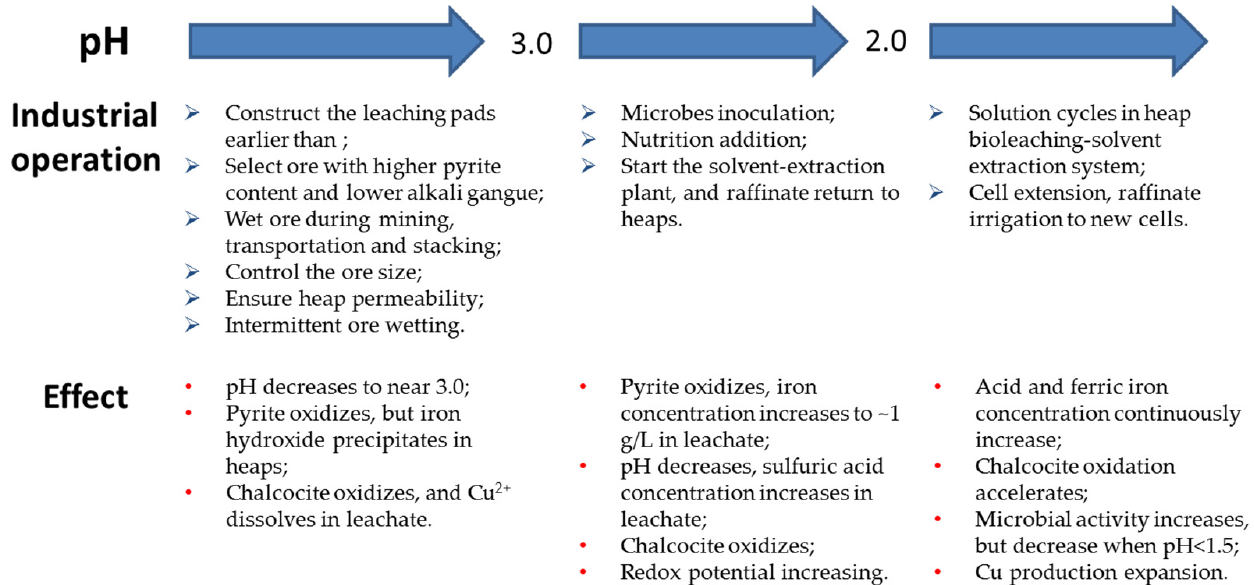
Figure 2. Scheme of the heap bioleaching started with only water irrigation. (1) pH > 3.0: Ore was wetted using river water at the ratio of about 4% during mining, truck transportation and stacking, for dust suppression and most important for starting the sulfide mineral oxidation. The cells were designed by the multi-lifts, and heap height were 6 m of each lift. No agglomeration and aeration were applied during heap bioleaching. Irrigation pipelines were installed immediately and irrigated on time with water to keep the ore wet. Under the neutral or slightly acidified condition, pyrite can reacts following reaction under the effect of oxygen (Equation (1))